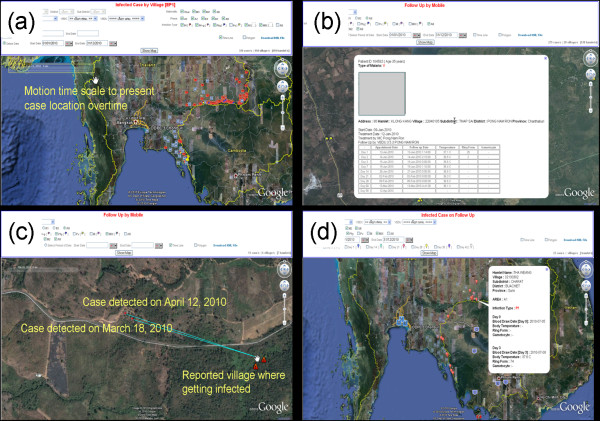
Examples of temporal and spatial presentations of malaria cases within the eMIS-GIS functionality. (a) P. falciparum cases mapped at village level with motion timescale to present locations of cases occurring during the selected time frame; (b) P. falciparum cases mapped at household level with follow-up details of a selected case’s demographics, temperature, and parasite/gametocyte data; (c) Self-reported locations of infection, based on case investigations; (d) Day 3 locations of positive cases on a map, with details of a selected case on follow-up parasite data.